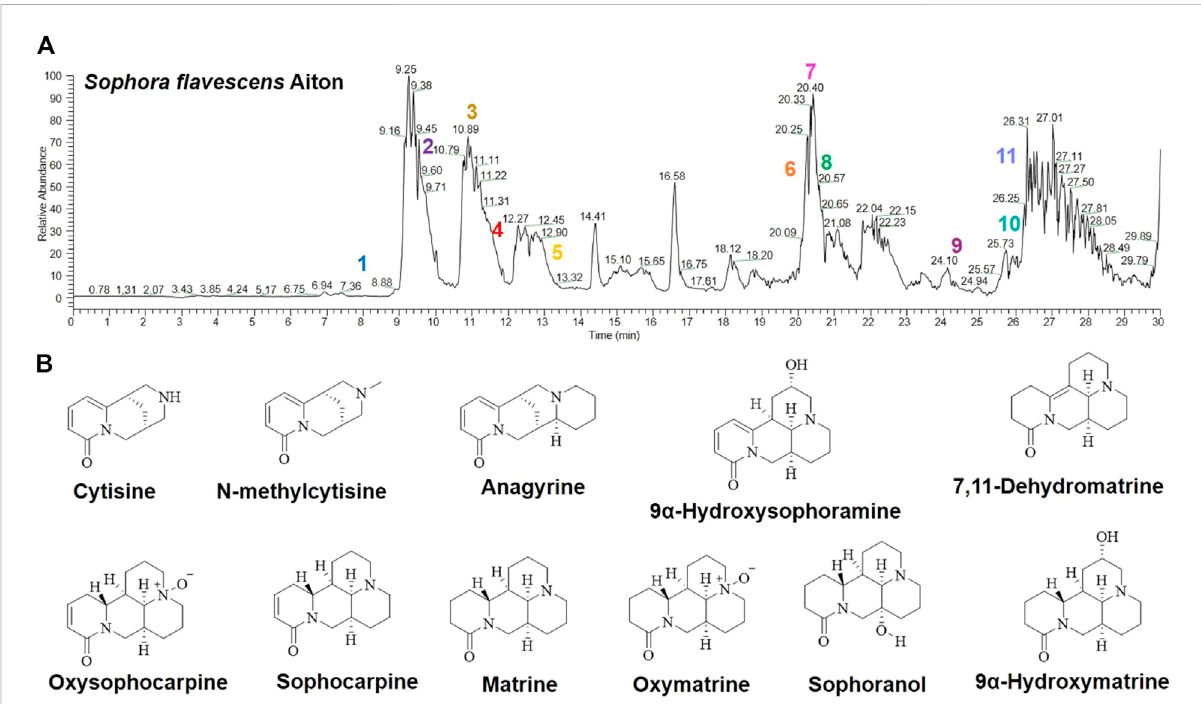
FIGURE 1 Analysis of SFAD by HPLC-MS. (A) HPLC-MS chemical fi ngerprint of SFAD. (B) Chemical structures of the major identi fi ed metabolites in SFAD by HPLC-MS: oxysophocarpine (1), N-methylcytisine (2), cytisine (3), sophoranol (4), oxymatrine (5), sophocarpine (6), 9 α -hydroxymatrine (7), anagyrine (8), 9 α -hydroxysophoramine (9), 7,11-dehydromatrine (10), and matrine (11).